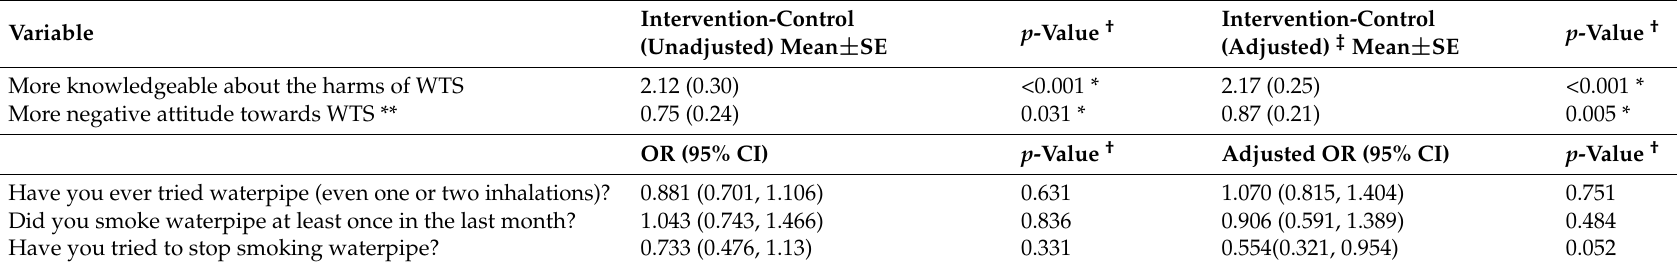
Table 4. Improvement in knowledge and attitudes